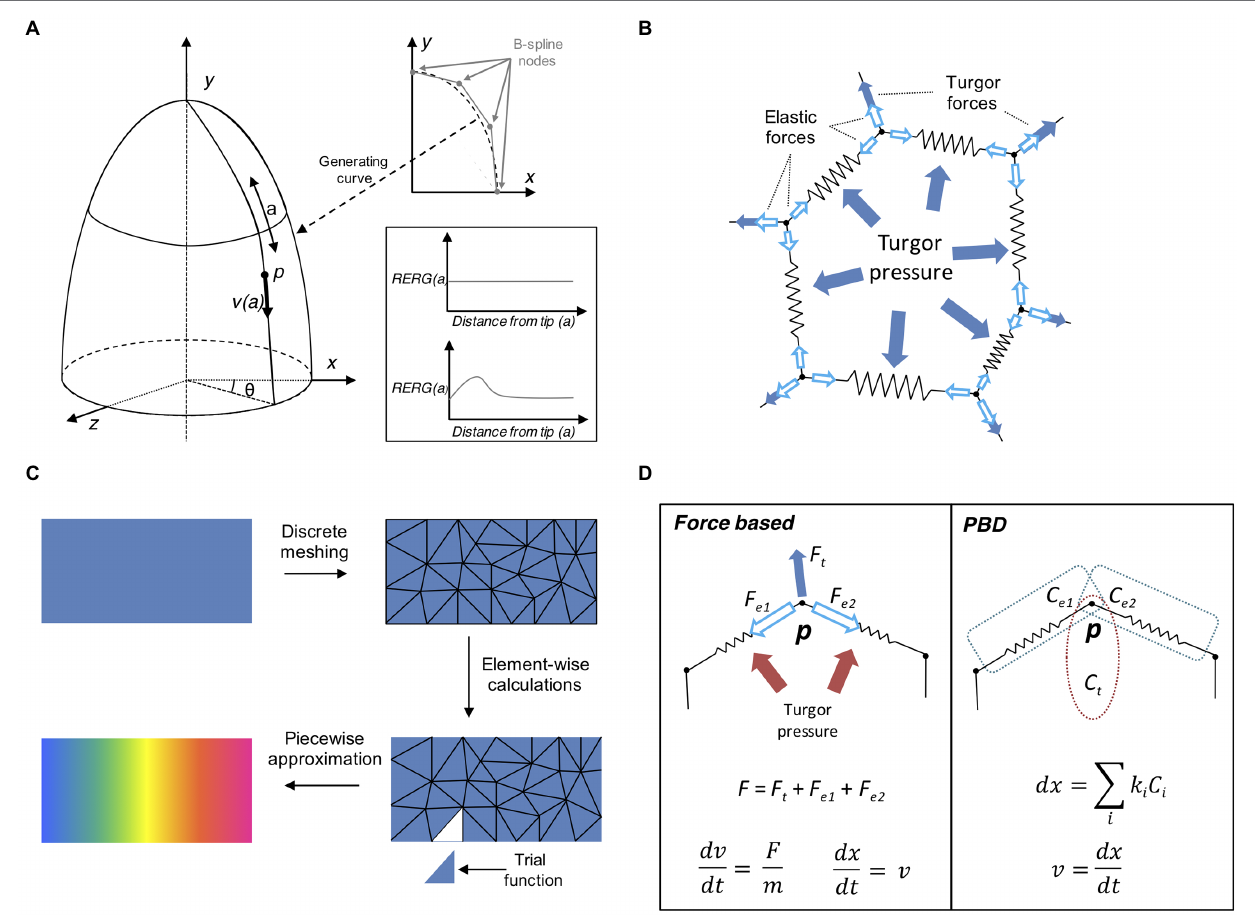
FIGURE 4 | Computational approaches to tissue growth dynamics. (A) A descriptive model of growth the shoot apex (adapted from Smith et al., 2006b). The shoot surface layer can be generated by a B-spline rotating around the longitudinal axis of the shoot apex (upper right plot). A point p located on the surface of the apex is located at coordinates ( θ , a ) moves away from the apex tip with the velocity v(a) , where a is the distance from the apex tip, measured along the curve on the apex surface. The shape of the generating curve and the angle θ determines the growth in Cartesian coordinates. The two sample plots show the relative elemental rate of growth (RERG) as functions of distance from the apex tip, either at constant growth (lower right box, upper plot) or with a decreased growth rate at the apex tip and flank (lower right box, lower plot). (B) Schematic of a cell represented by the mass–spring system. The cell wall is a polygon whose vertices and edges are masses and springs, respectively. The effect of internal turgor pressure generates forces perpendicular to the wall edges, and distributed over the vertex masses. The vertices movement is further restricted by the elastic forces exerted by the springs. (C) Schematic representation of the finite element method (FEM). A continuous object for which a global function of growth needs to be approximated is subdivided into a conglomerate of smaller geometrically manageable finite elements (triangles in this case) in a process called “meshing.” Each element is represented by a set of piecewise linear equations (sometimes called “trial” functions) derived from the original problem. After the calculations are done for each finite element all sets of equations are systematically recombined into a global system that approximates the original one. Generally, a finer meshing results in a better approximation. (D) Comparison between the force- based approach and position based dynamics (PBD). In a force based approaches the total cumulative force is calculated for each physical entity. For instance, a mass–spring system includes the total force acting on the vertex via internal turgor pressure and the elastic forces of the springs. Acceleration and velocity are calculated for each time step (usually recurring to explicit or implicit integrating solvers), and the object position is finally updated. In the PBD approach, the object is subjected to different constraints instead (in this case, two distance constraints and an area constraint, see Müller et al., 2007; Marconi et al., 2021), and each constraint is sequentially projected on the object updating its position. The vertex velocity is recalculated in the final